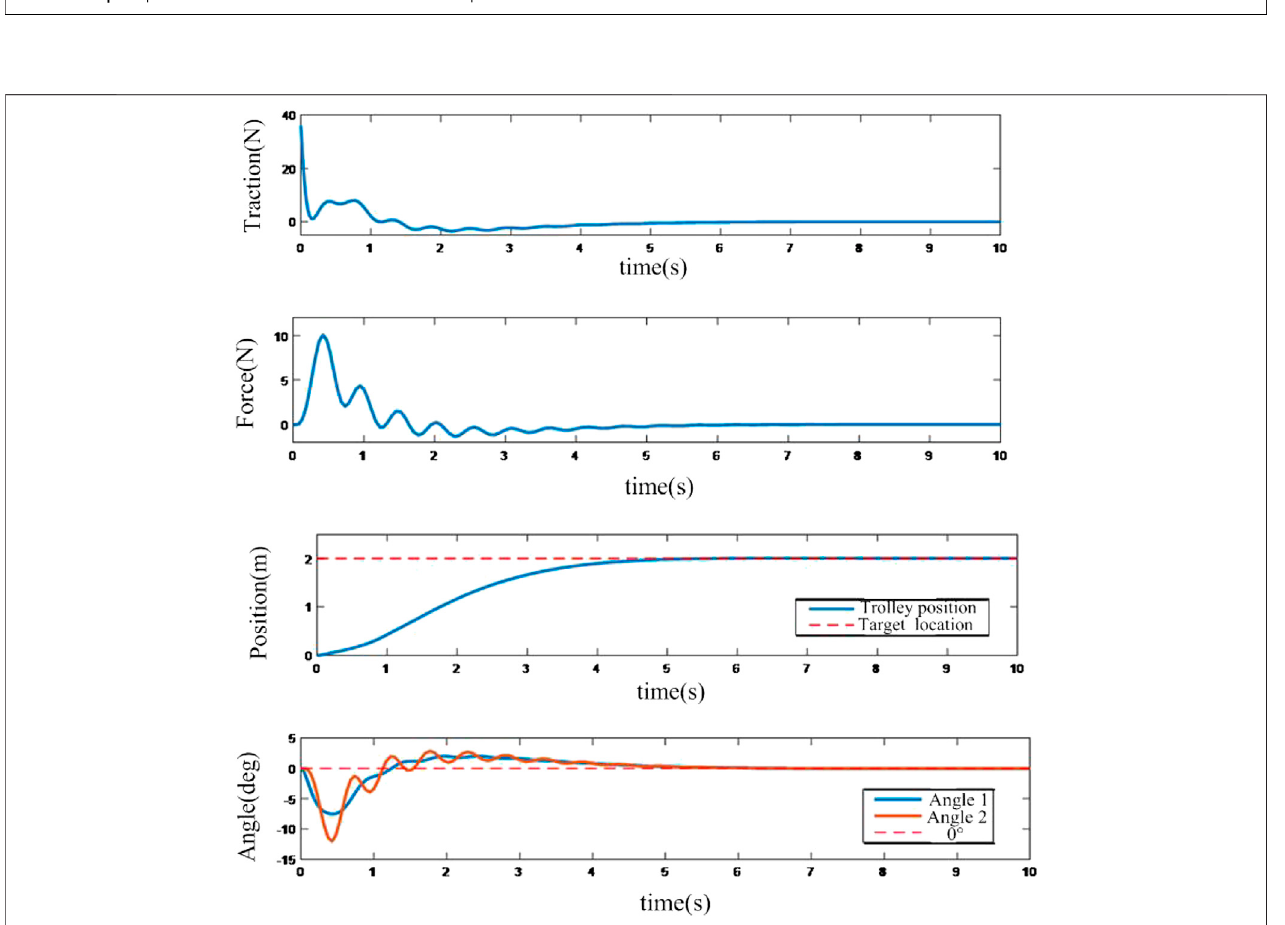
FIGURE 4 | Neural network control response of the control